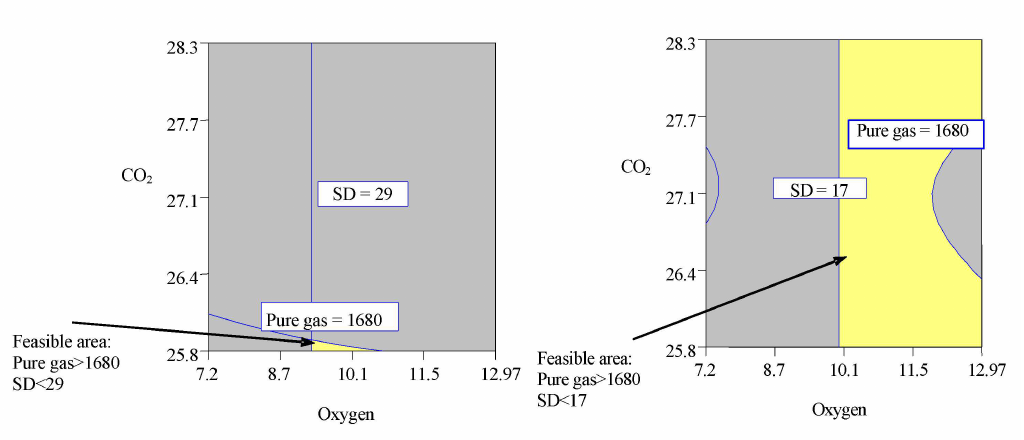
Figure 3: Operability regions for ˆ E ( y ( x, w, z = 10)) ≥ c 1 m 3 n/t DAF and ˆ σ simultaneously for unwashed coal: (a) Typical broad PSD with c 1 = 1 680 m 3 n/t DAF and c 2 = 29 m 3 n/t DAF, (b) Finer PSD with c 1 = 1 680 m 3 n/t DAF and c 2 = 17 m 3 n/t